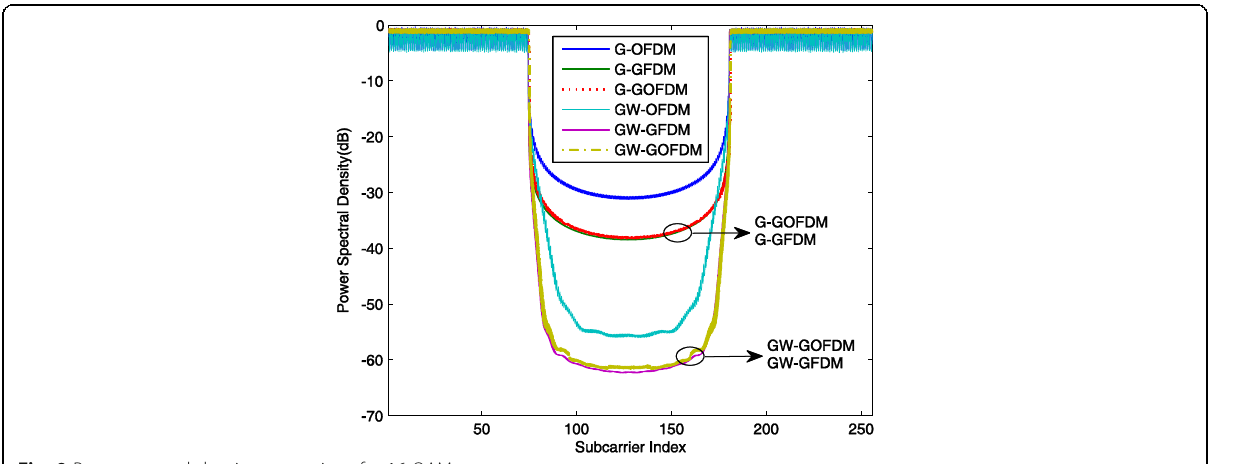
Fig. 9 Power spectral density comparison for